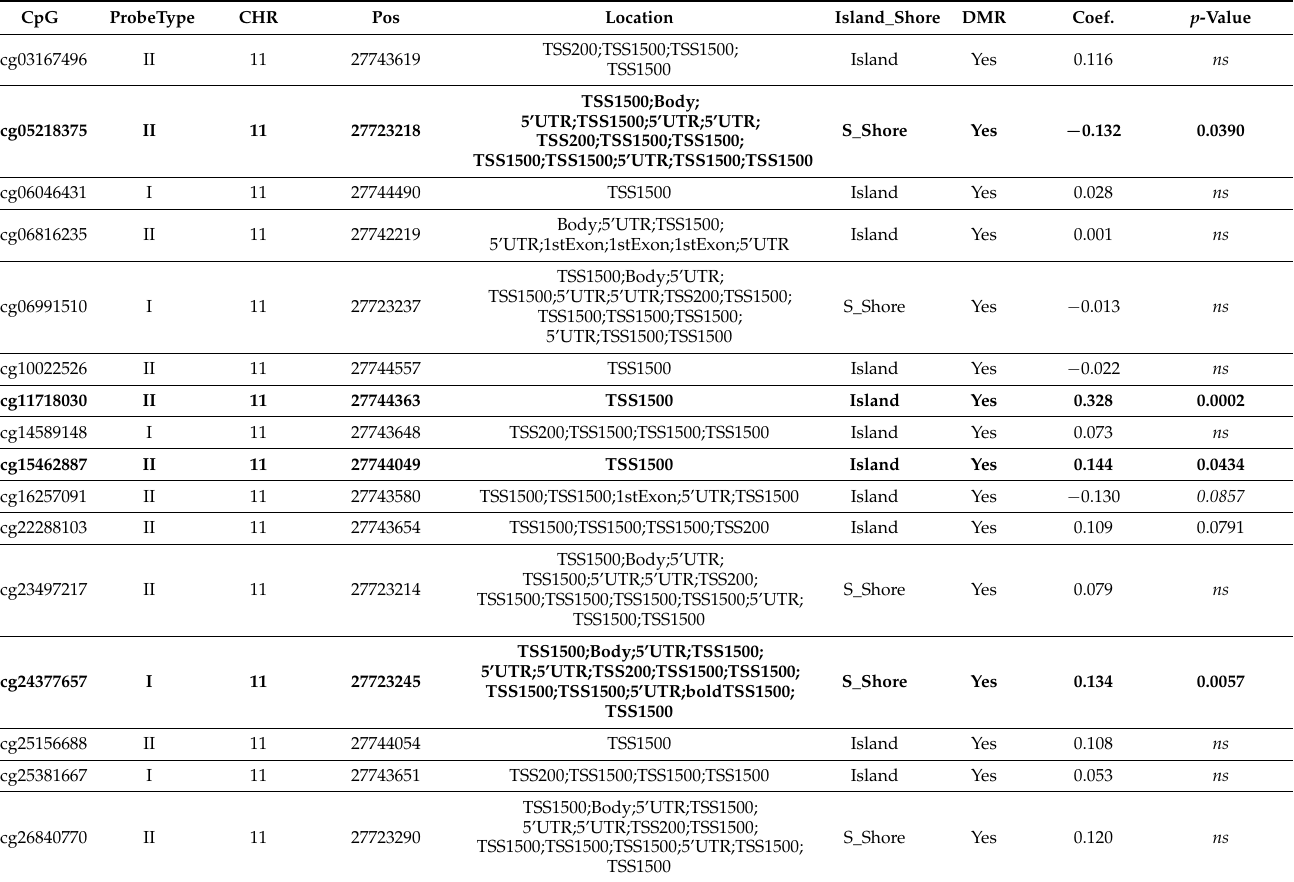
Table 3. Robust Linear Regression Contrasting Individual BDNF Methylation M-values to Disease Status (EUPD or